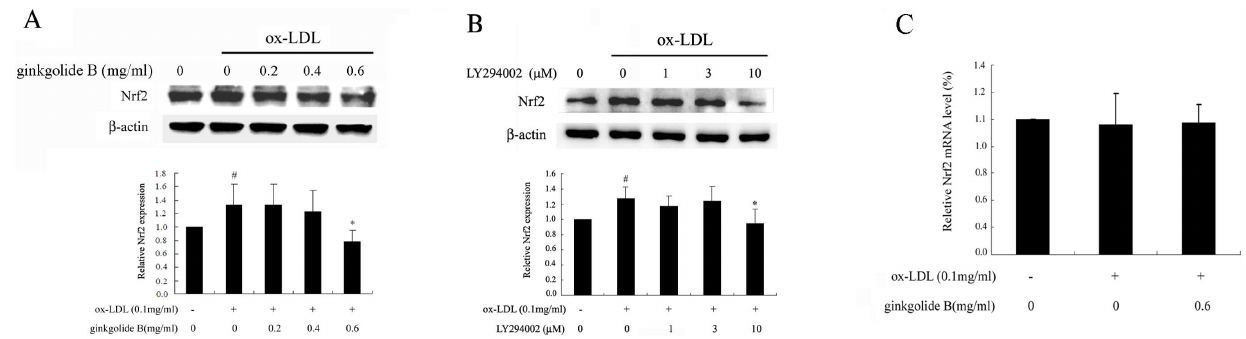
Figure 7. Ginkgolide B decreases Nrf2 expression without reducing the level of Nrf2 mRNA in ox-LDL-stimulated endothelial cells. (A) Ginkgolide B downregulated Nrf2 expression. (B) LY294002 recovered Nrf2 expression. The data were obtained from five